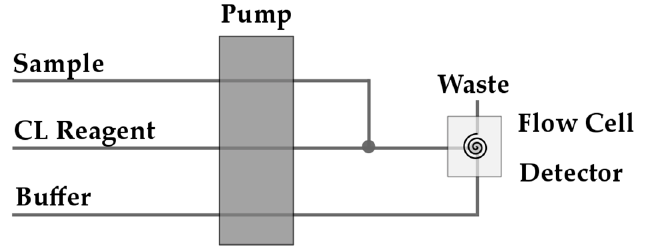
Figure 5. Flow injection analysis (FIA) setup for H 2 O 2 detection. The sample and the chemiluminescent (CL) reagent are mixed and the pH is adjusted by the buffer in the flow cell. The signal is detected there (with a photo multiplier tube (PMT)). Depending on the system, a washing solution (diluted HCl) can be added to avoid clocking of the system; this is useful especially when working with seawater. With more complicated systems a multivalve for sample injection can be used. For more information see for example King et al. [128].